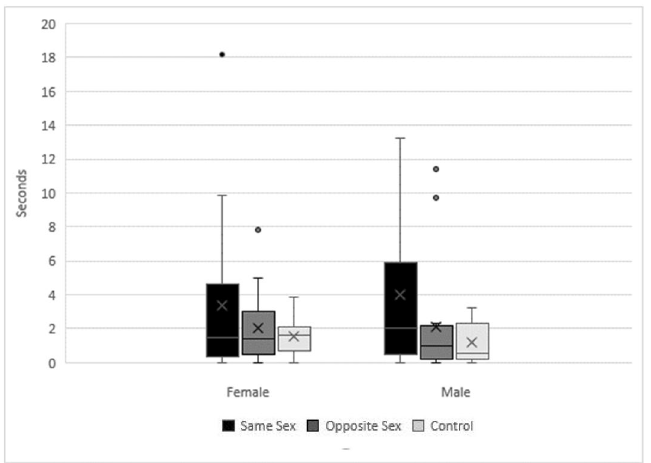
Figure 1. The amount of time in seconds that dogs spent sniffing pedal scent samples from their own sex (black), the opposite sex (medium gray), and control (light gray). Error bars represent the standard error of the mean (SEM).